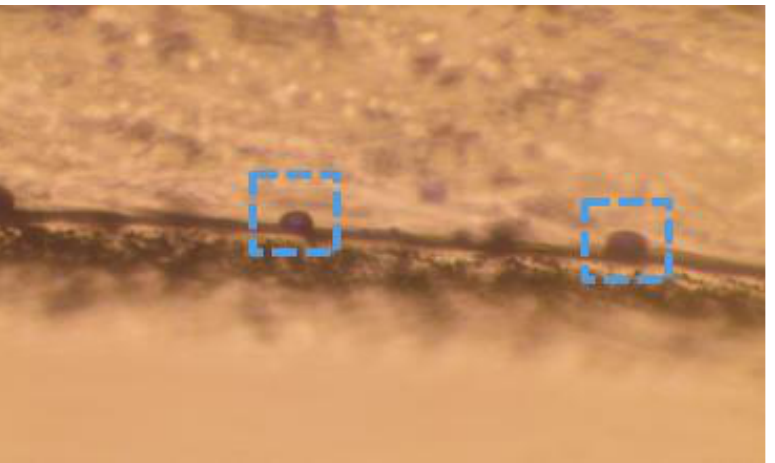
Figure A3. The experiment of ink-in-oil at 1200 rpm. There was ink (blue) residue on the wall surface of the flowing channel.